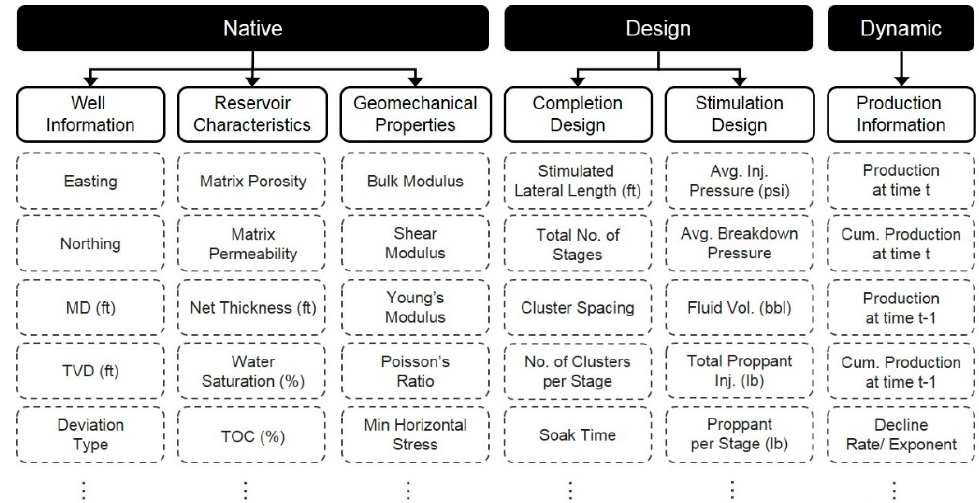
Figure 2. List of native, design, and dynamic attributes in shale formations.